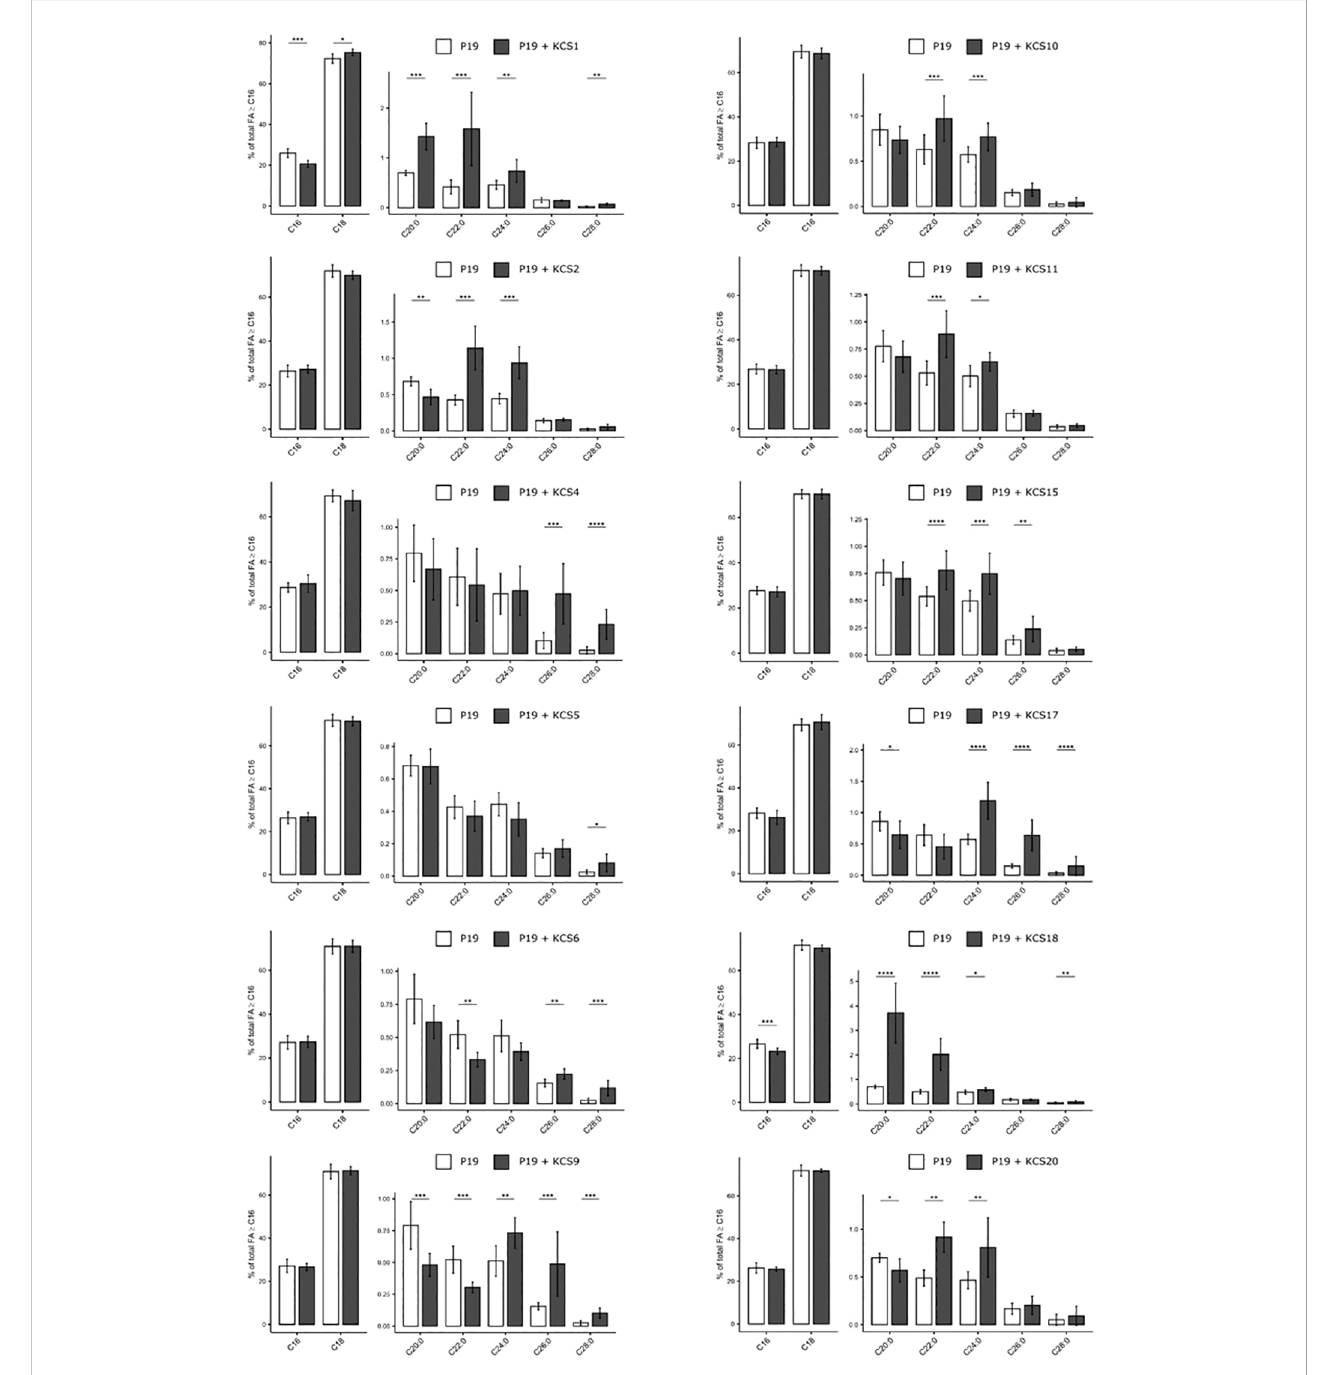
FIGURE 6 Heterologous expression of 12 AtKCS impacts FAMEs composition of Nicotiana benthamiana leaves. Comparison of FAMEs pro fi les obtained in leaves co- expressing KCS and the gene silencing suppressor P19 with the control condition (leaves transformed with P19 only). Mean values (percentage of total FA > or = C16) are given with SD (n>6). Signi fi cant changes were determined through a Wilcoxon test (*P < 0.05, **P < 0.01, ***P < 0.001, ****P < 1e -4